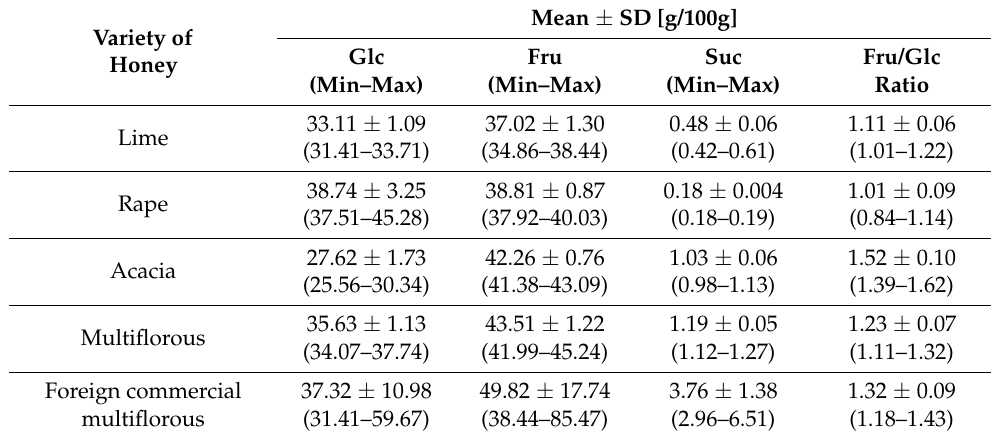
Table 1. Comparison of average sugar content in different varieties of